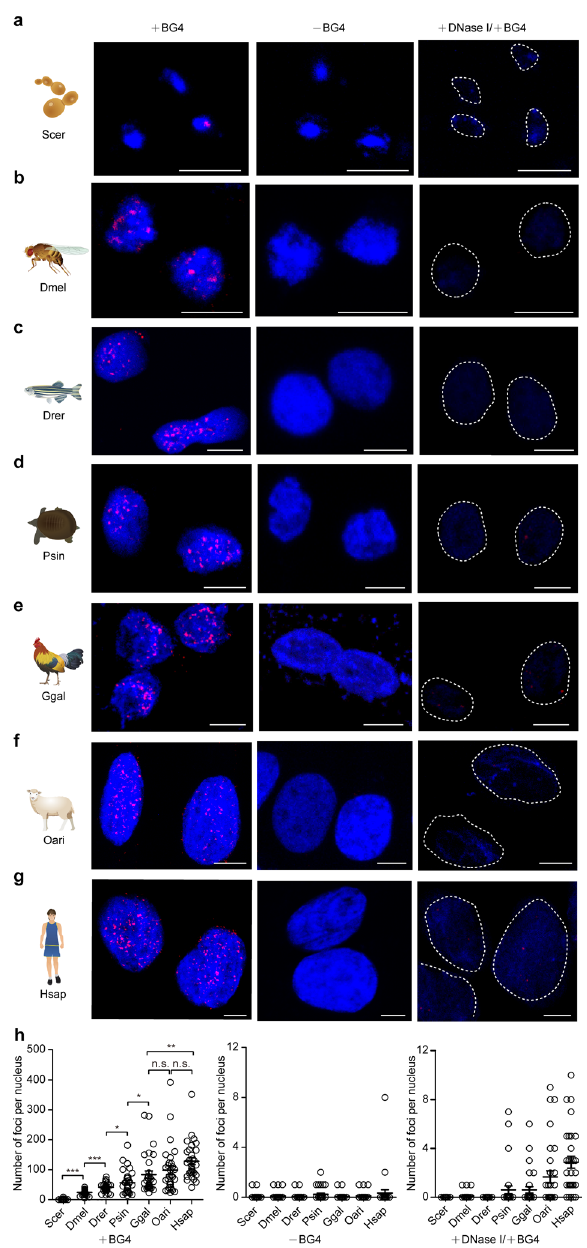
Fig. 3 Detection of the G4 structures in the representative species by immuno fl uorescence staining. a – g Immuno fl uorescence staining signals showing the G4 structures in Saccharomyces cerevisiae (Scer), Drosophila melanogaster (Dmel), Danio rerio (Drer), Pelodiscus sinensis (Psin), Gallus gallus (Ggal), Ovis aries (Oari), and Homo sapiens (Hsap). h Quanti fi cation statistics of the number of G4 structures per nucleus in Scer, Dmel, Drer, Psin, Ggal, Oari, and Hsap cells. Signal spots in 30 nuclei from three replicates (ten nuclei for each replicate) were counted for each species. Data are the mean ± SEM ( n = 30), statistical signi fi cances were determined by Student ’ s t test, * p < 0.05, ** p < 0.01, and *** p < 0.001. The scale bars equal 5 μ